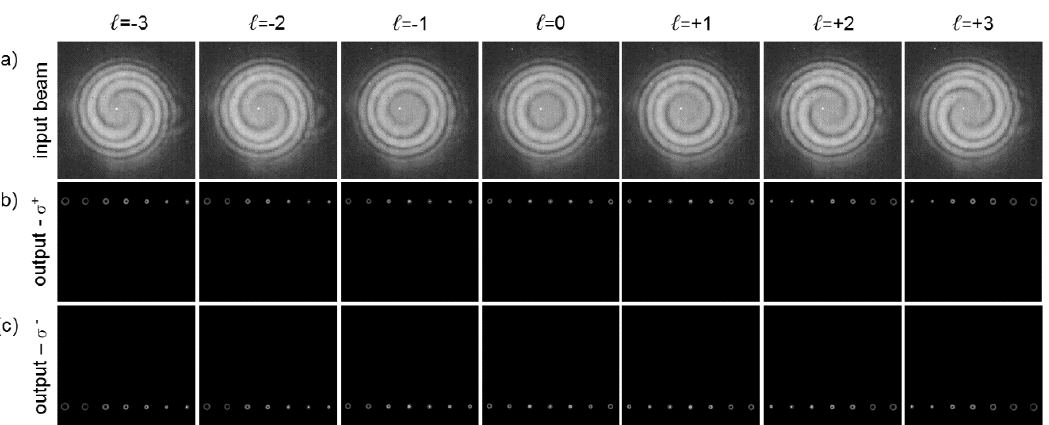
Figure 7. Optical characterization of the demultiplexer in Figure 2. ( a ) Experimental interference pattern of the input beams. The twist-handedness and number of the spiral arms reveal the sign and value of orbital angular momentum, respectively. Experimental output intensity for input right-handed ( b ) and left-handed ( c ) circular polarization states. The position of the far-field bright spots is in accordance with the channel scheme depicted in Figure 2b.